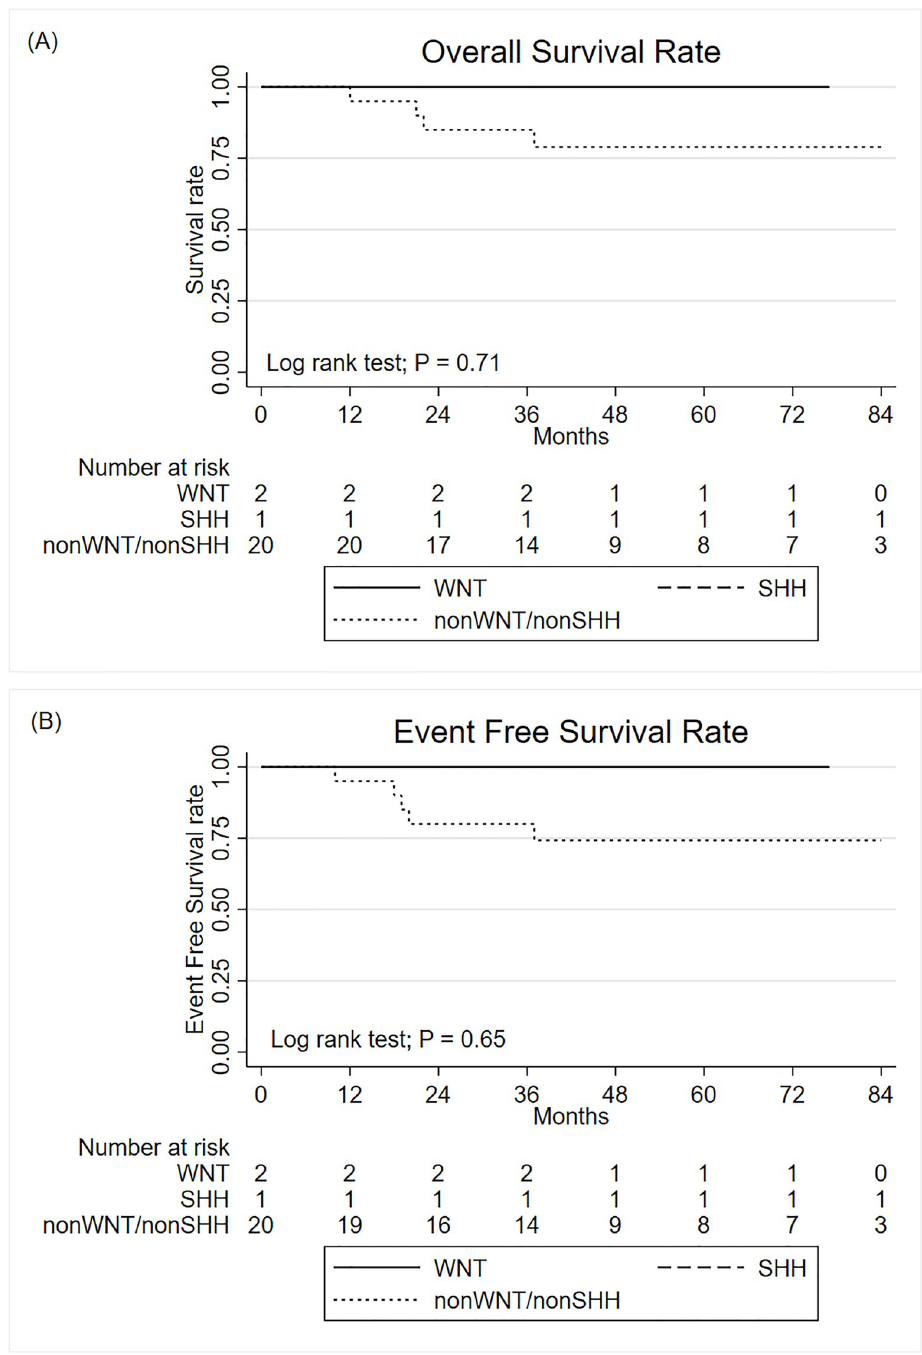
Fig 3. The Kaplan-Meier curve for overall survival (A) and event free survival (B) of medulloblastoma by molecular subtypes.